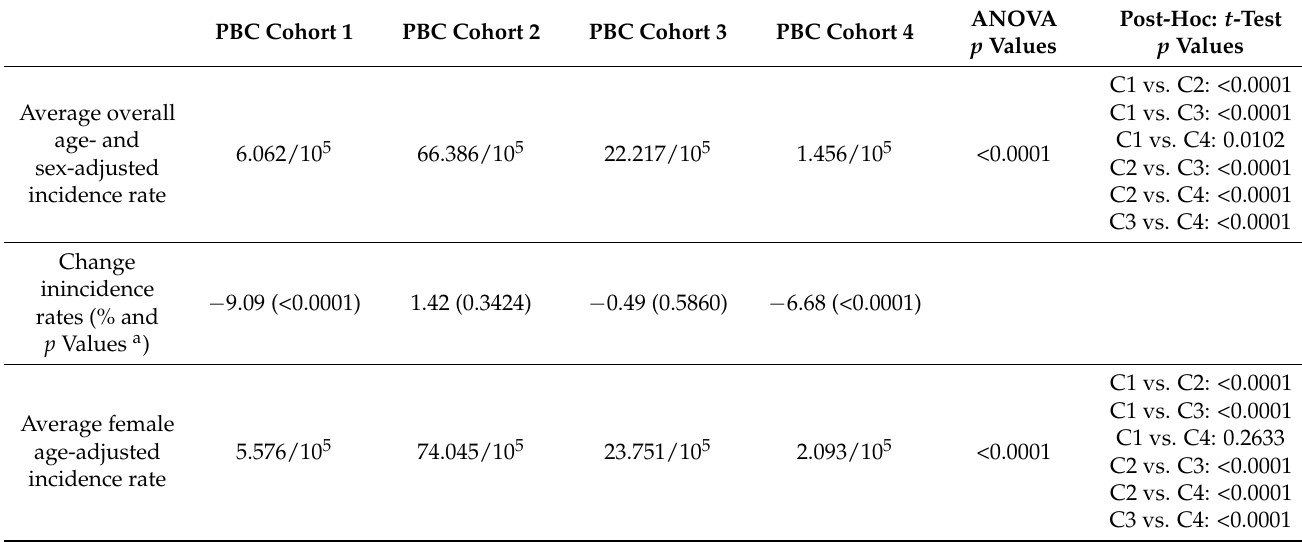
Figure 2. The trends in age- and sex-adjusted prevalence ( A – D ) and incidence ( E – H ) rates (per 10 5 ; mean ± 95% confidence interval of prevalence rates). ( A ), Prevalence rates in PBC cohort 1. ( B ), Prevalence rates in PBC cohort 2. ( C ), Prevalence rates in PBC cohort 3. ( D ), Prevalence rates in PBC cohort 4. ( E ), Incidence rates in PBC cohort 1. ( F ), Incidence rates in PBC cohort 2. ( G ), Incidence rates in PBC cohort 3. ( H ), Incidence rates in PBC cohort 4. Table 3. Incidence rates of the 4 PBC